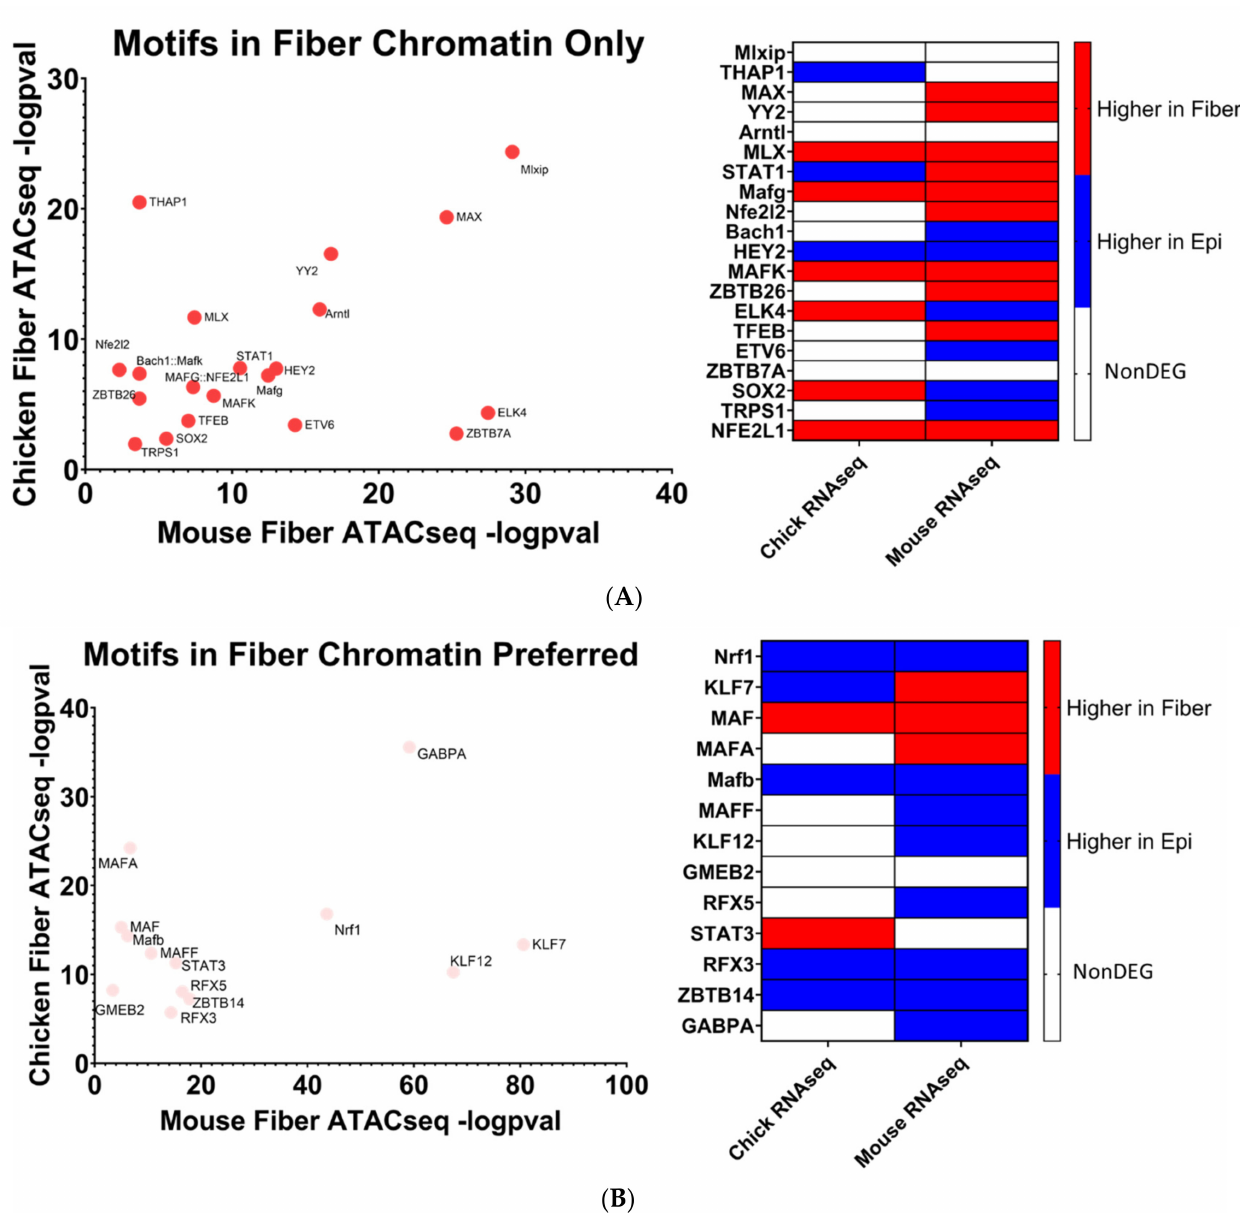
Figure 10. Transcription factor motifs enriched in open chromatin near evolutionarily conserved fiber cell genes. ( A ) Transcription factor motifs enriched only in open chromatin near fiber cell genes. ( B ) Transcription factor motifs more significantly enriched in open chromatin near fiber cell genes compared to epithelial cell